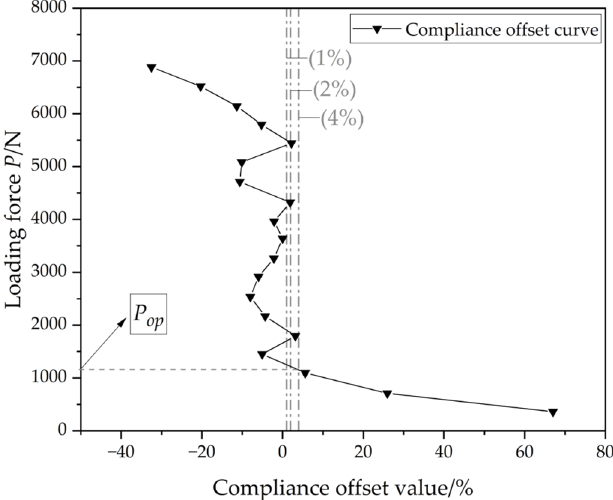
Figure 6. Loading force versus compliance offset value curve of CT01.